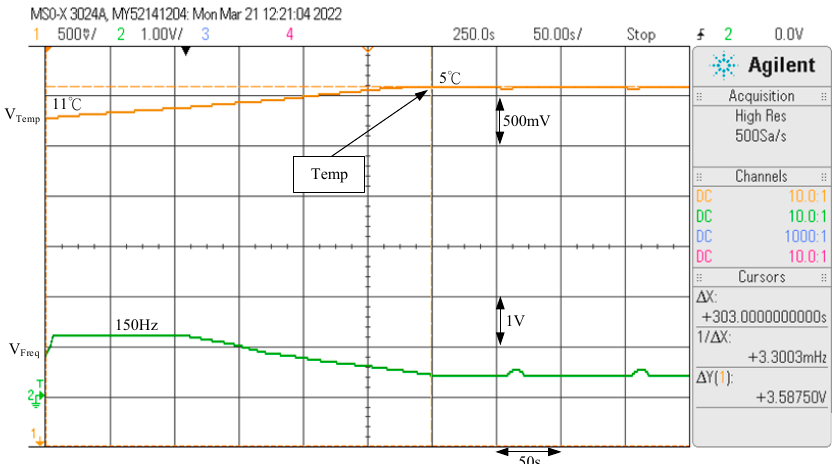
Figure 32. Response waveform of the temperature control with the conventional P-I controller (control the temperature to change from 11 °C to 5 °C).